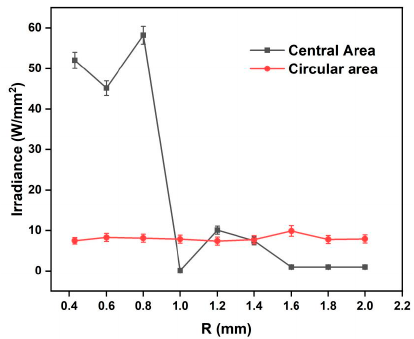
Figure 5. Simulation of the energy on the annular and central areas of the focal plane of AFZPs with different radii R.